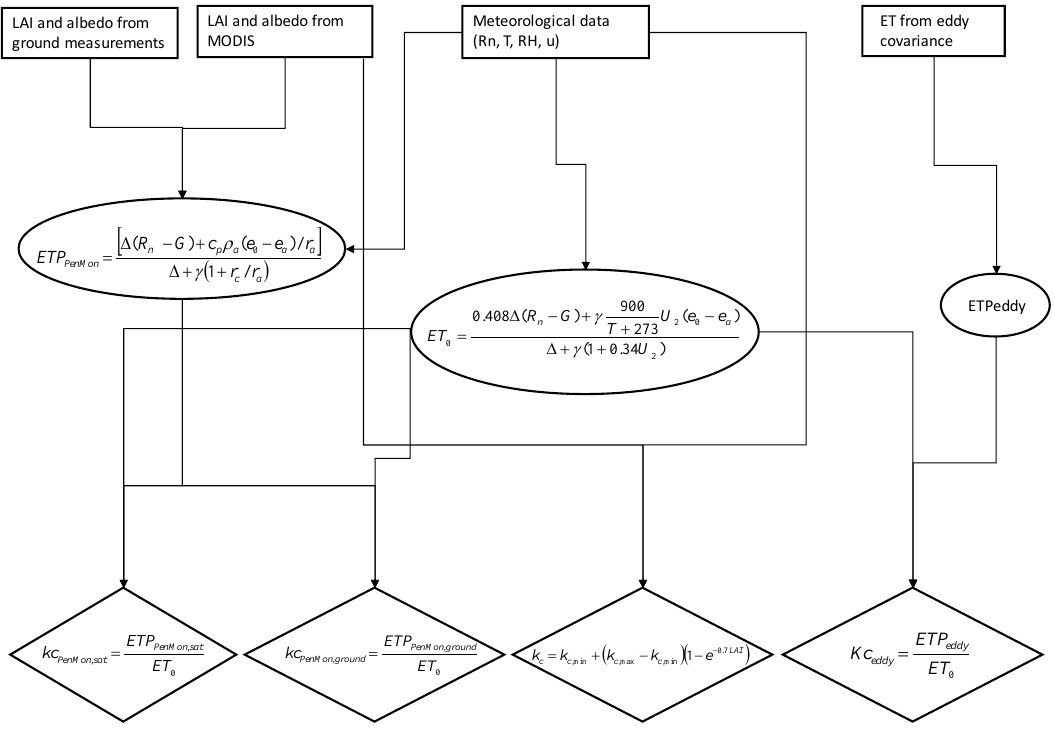
Figure 1. Methodology to compute crop coefficients with the four different techniques.